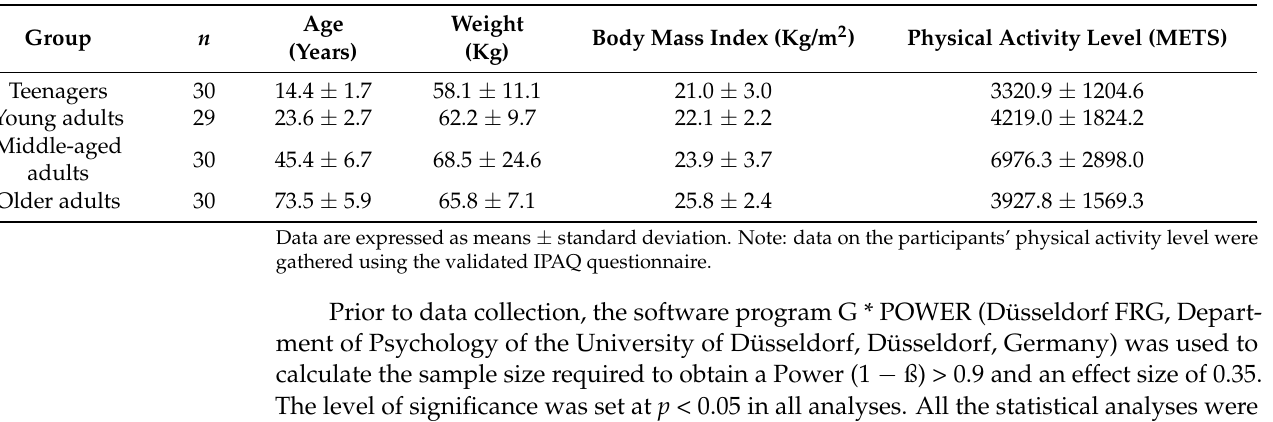
Table 1. Demographic characteristics of the